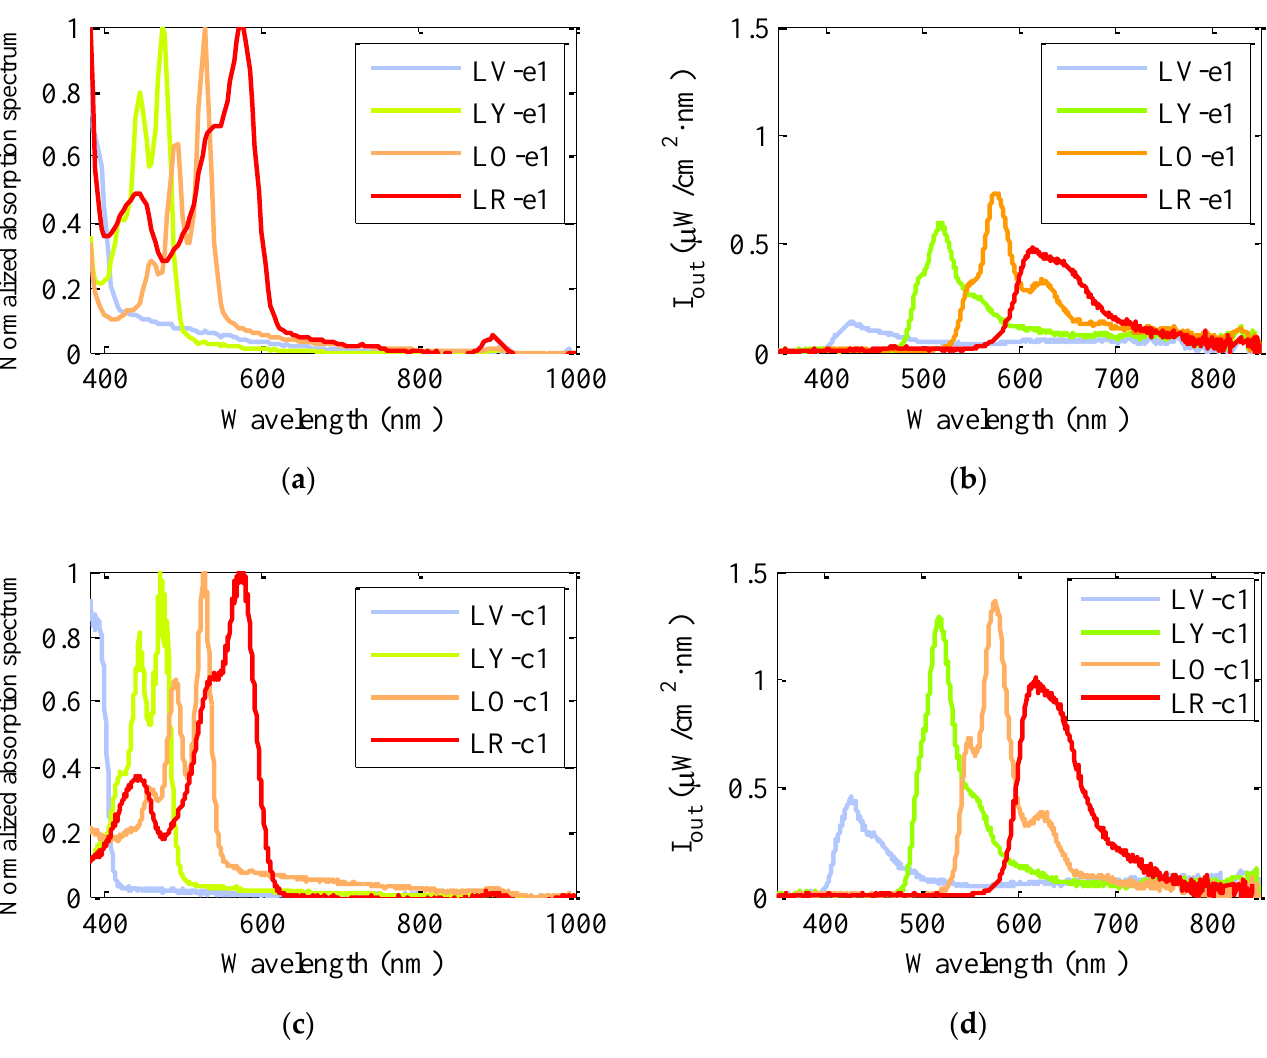
Figure 3. Relative absorption and absolute emission spectra of dye-doped fiber samples made by extrusion method ( a , b ) and casting method ( c , d ) (with z e = 5 cm and z ne = 0). The main absorption peaks for the LV, LY, LO and LR fibers are located at 392, 472, 524 and 575 nm, respectively, and the emission peaks lie at 427, 518, 575 and 616 nm.